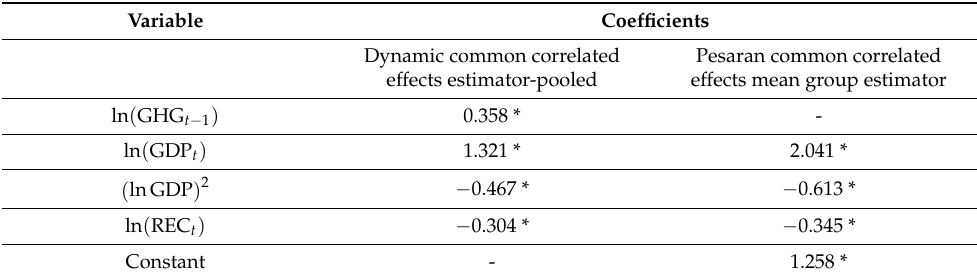
Table 8. Dynamic and Pesaran common correlated effects estimators to explain GHG emissions in RKC (basic model).